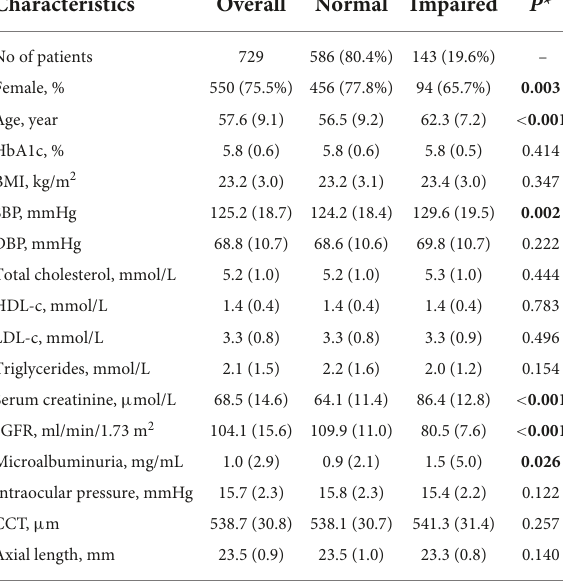
TABLE 1 Demographic and clinical characteristics of study